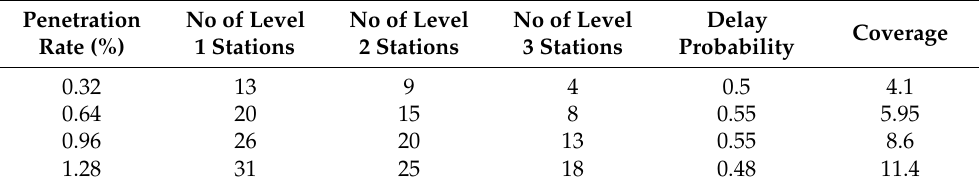
Table 6. Summary of the planning results of MS I.